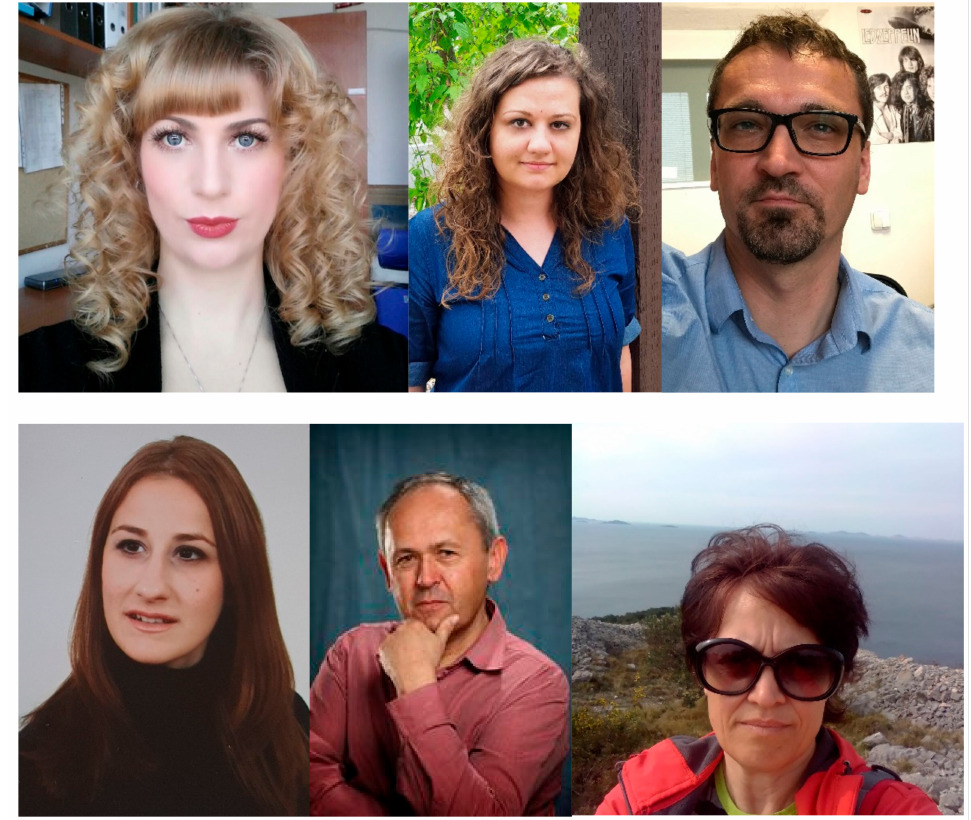
Figure 2. Ida Lini´c, Dunja Šamec, Jiˇr í Gr ú z, Valerija Vujˇci´c Bok, Miroslav Strnad and Branka Salopek- Sondi (from up to down and from left to